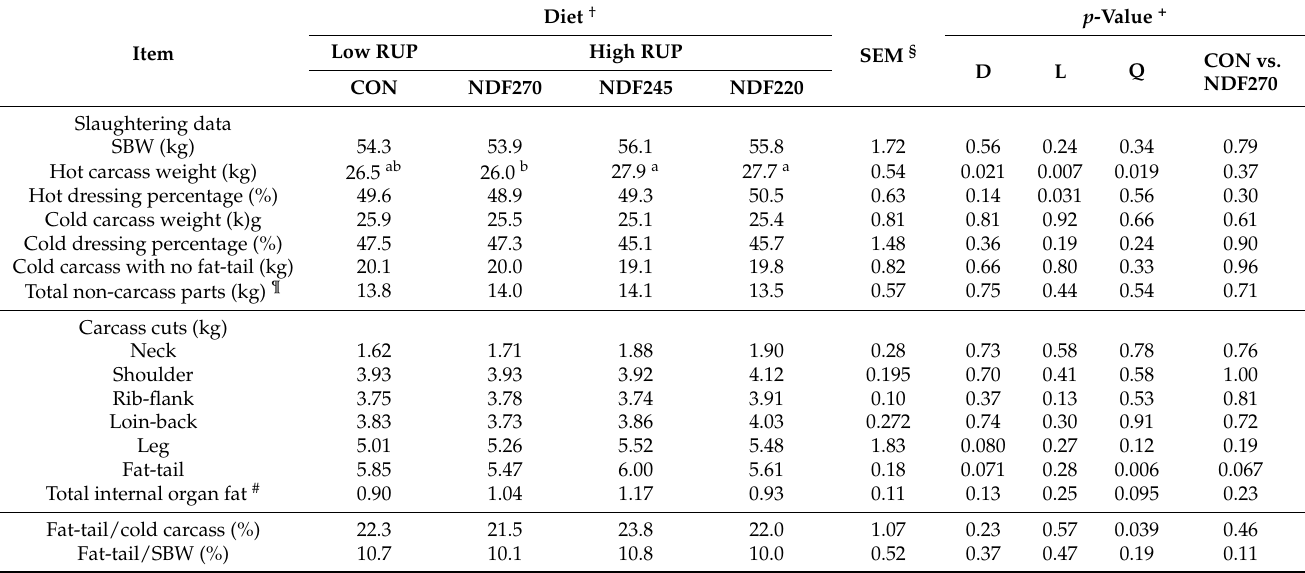
Table 7. Effects of feeding different levels of neutral detergent fiber (NDF) and rumen undegradable protein (RUP) on slaughter and carcass quantitative traits of fat-tailed lambs.